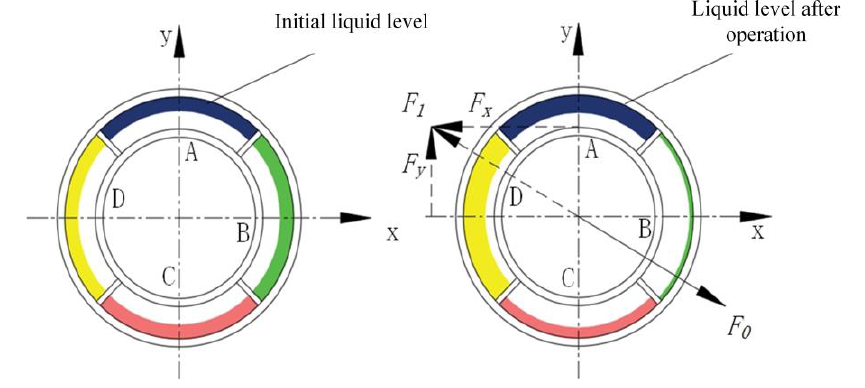
Figure 4. Schematic diagram of the actuator balancing